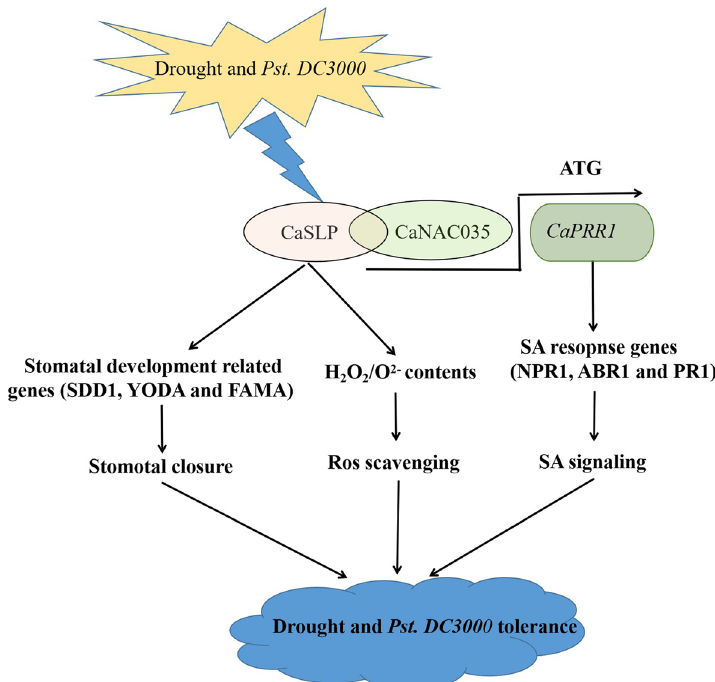
Fig. 11 In this model, Proposed model for CaSLP in response to drought and Pst.DC3000 tolerance stress through three main mechanisms: (1) By interacting with CaNAC035, CaSLP alleviates water loss by stimulating stomatal closure and reducing stomatal density; (2) Upon exposure to drought and SA stresses, CaSLP mediated drought and Pst.DC3000 resistance stress was cleared by ROS; (3) CaNAC035 interacts with CaSLP, and CaNAC035 acts as a transcriptional activator binds to the promoter of CaPR1 to modulate the drought and Pst.DC3000